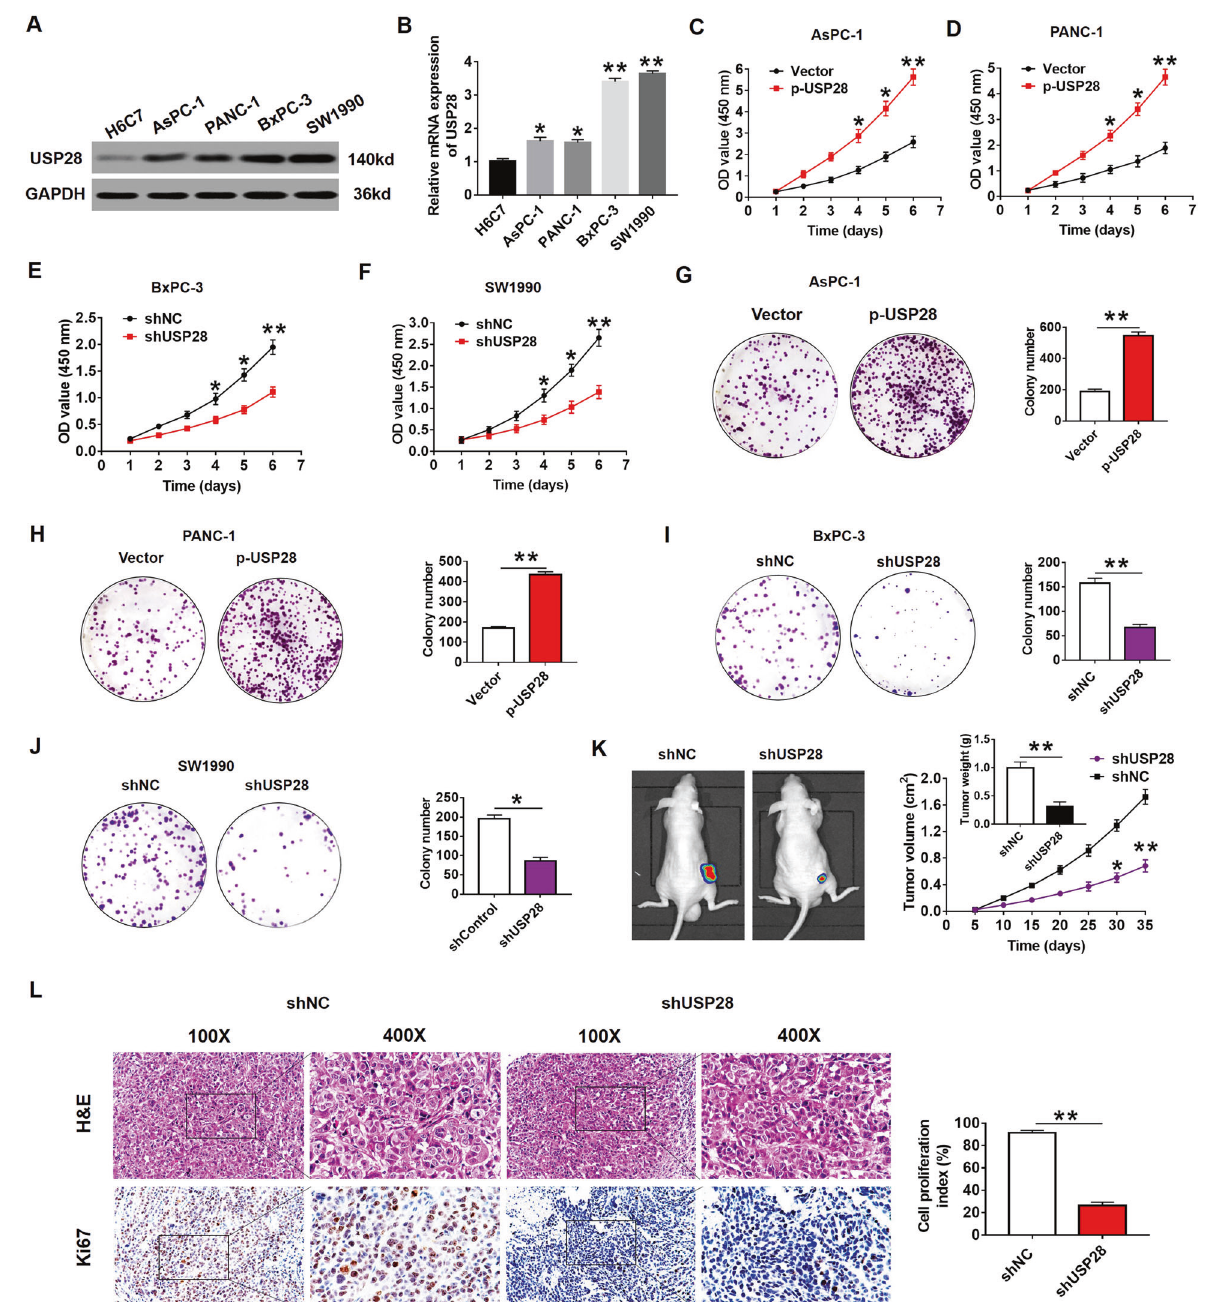
Fig. 2 Effects of USP28 on PC cell growth. A , B The protein and mRNA levels of USP28 in four PC cells and the immortalised H6c7 line. C – F CCK-8 assay showing proliferation of PC cells following overexpression ( C and D ) or knockdown ( E and F ) of USP28. Data represent mean ± SD of triplicate experiments and were statistically analysed with Student ’ s t test, * P < 0.05, ** P < 0.01. G – J Representative images (left) and quanti fi cation (right) of colony formation assays of pancreatic cancer cells transfected with p-USP28 ( G and H ) or shUSP28 ( I and J ). The data represent mean ± SD from three independent experiments and were statistically analysed with Student ’ s t test, * P < 0.05, ** P < 0.01. K Bx P C-3/ shUSP28 cells were subcutaneously injected into nude mice, and tumour volumes were measured on the indicated days; at the experimental endpoint, tumours were dissected, photographed and weighed. n = 6, * P < 0.05, ** P < 0.01. L Representative H&E staining in tumour tissues isolated from USP28-silencing and control nude mice. And, cell proliferation in tumour tissues isolated from USP28-silencing nude mice was determined by Ki67 staining. Cell proliferation index was quanti fi ed by counting the proportion of nuclear Ki67-positive cells (magni fi cation ×100, inset magni fi cation ×400). ** P < 0.01. Scale bar, 50 μ the activation of the TOP-Flash reporter in BxPC-3 cells in the Wnt3a, we found that increased expression of USP28 in AsPC-1 absence of recombinant human Wnt3a (supplementary Fig. 3). cells signi fi cantly enhanced the activity of TOP-Flash reporter; Importantly, compared with the control cells, the level of nuclear whereas, USP28-silencing resulted in the decreased activity of the β -catenin was dramatically increased in PC cells with USP28 TOP-Flash reporter. In addition, knockdown of USP28 also inhibited